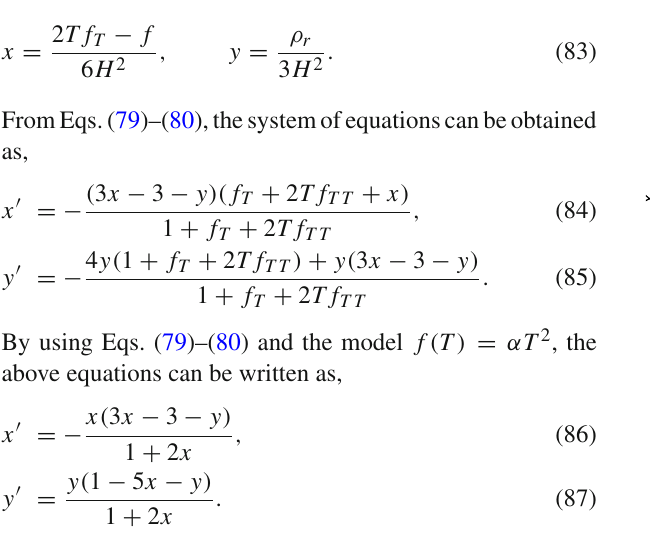
Fig. 8 Phase plot for the system of Eqs. (79)–(80)